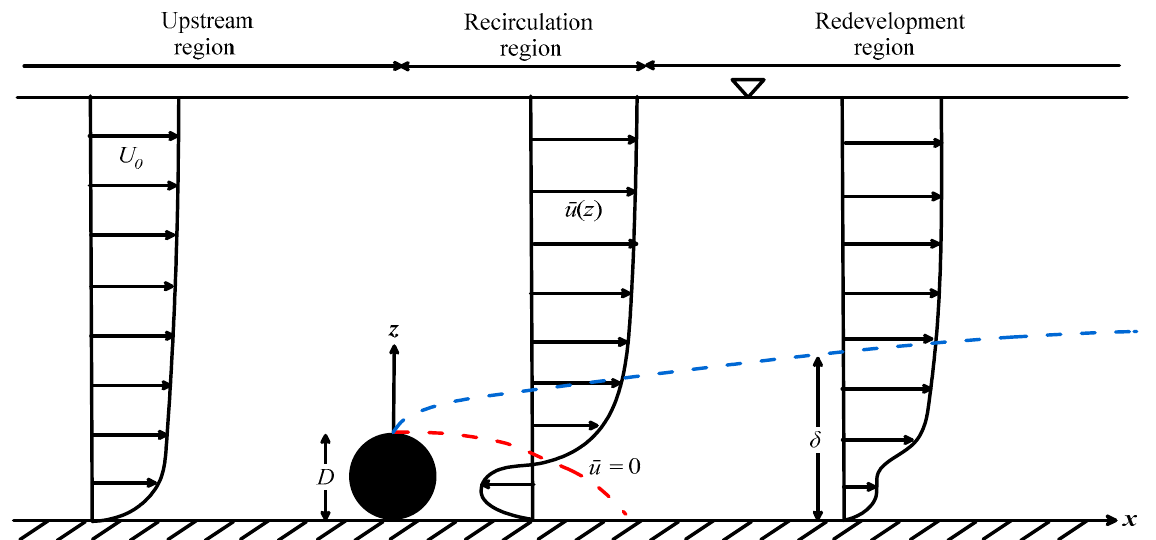
Figure 5. Schematic of different regions of flow field upstream and downstream of a circular cylinder.